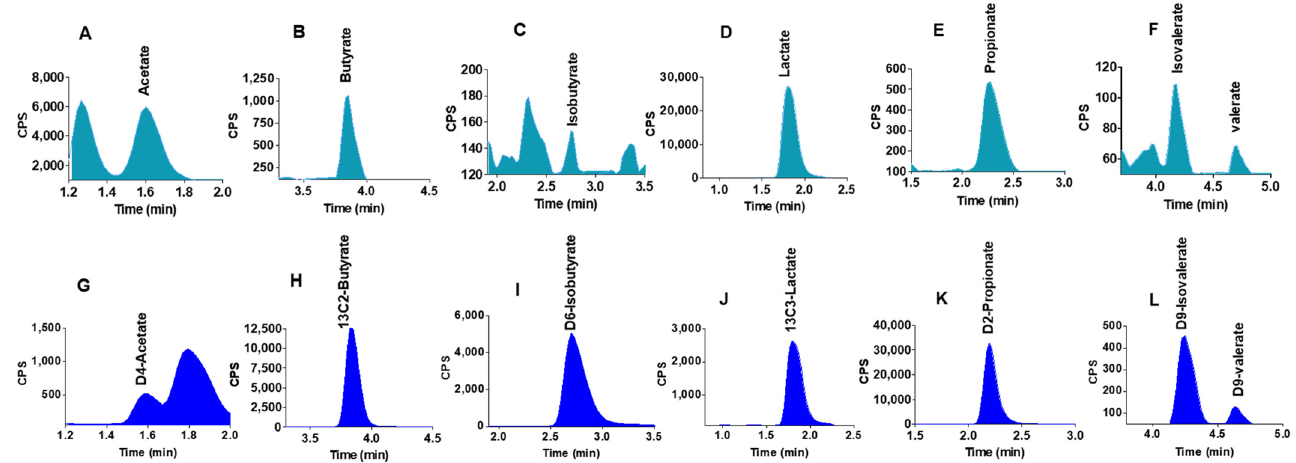
Figure 3. LC-MS generated SCFA peaks in mouse liver samples. ( A – F ) peaks detected in mouse liver samples. ( G – L ) corresponding labelled internal standards of SCFA in mouse liver samples.